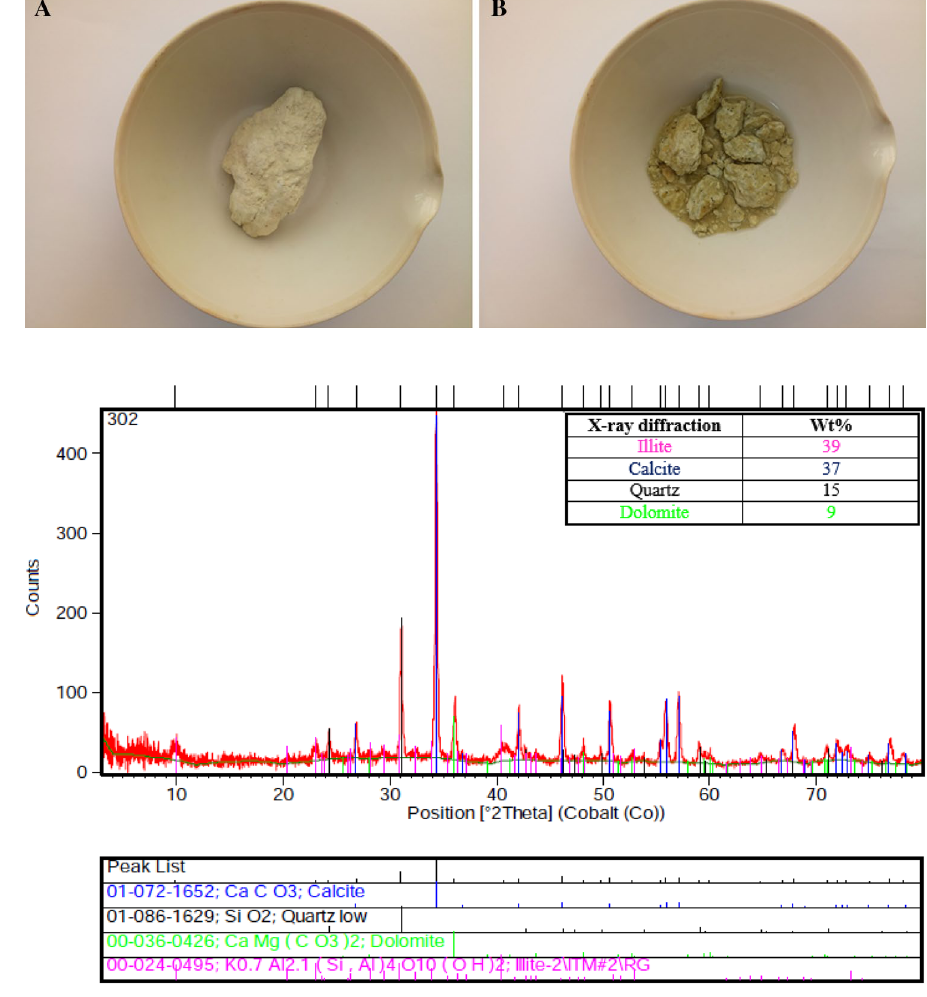
Fig. 2 Behavior of Pabdeh shale sample: a before contacting with water and b after 24 h contacting with water